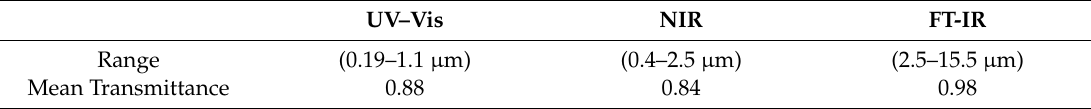
Table 1. Measured mean transmittance for the selected low-density polyethylene (PELD)